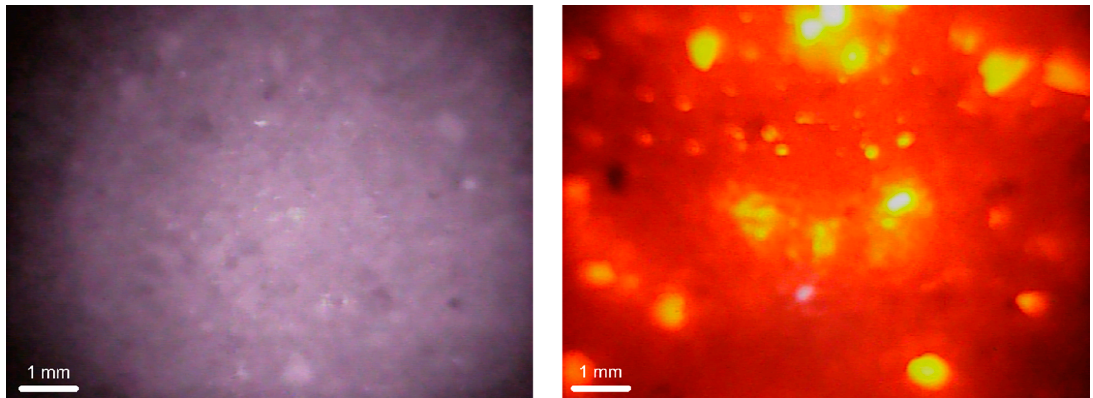
Figure 10. Sample CA-fluo0.2 embedded in a quartz sand matrix under infrared light ( left ) and excited at 520 nm ( right ).